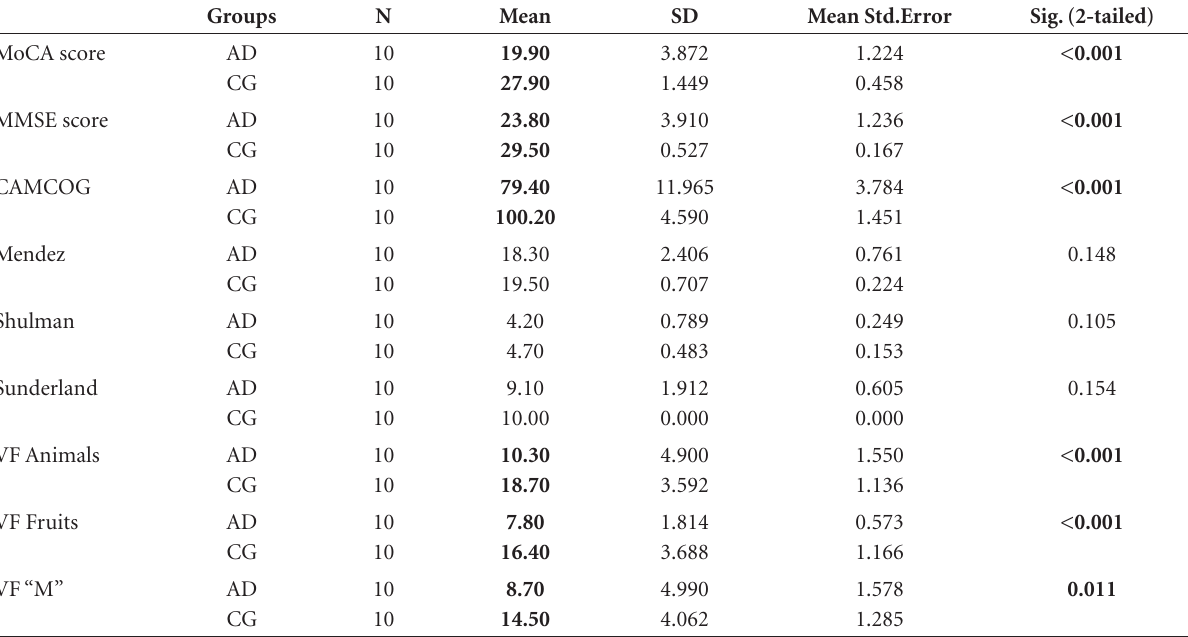
Table 2. T-test analyses of cognitive evaluations, age and education in 20 subjects by CG and AD. Groups N